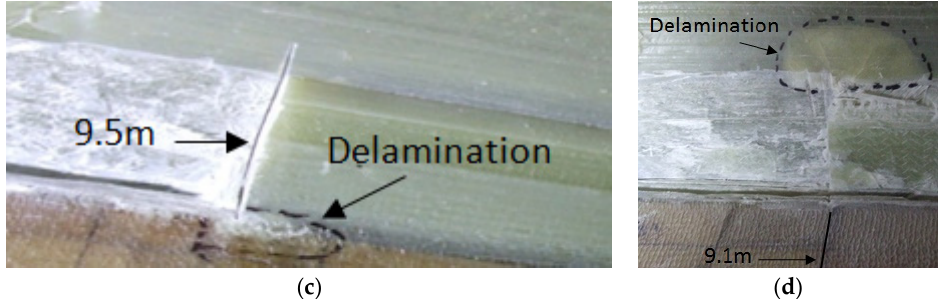
Figure 14. Damaged areas around the root: ( a ) delamination at 8.5 m ( b ) adhesive joint failure at 8.5 m; ( c ) delamination inside the web box at 9.5 m and ( d ) delamination inside the web box at 9.1 m.